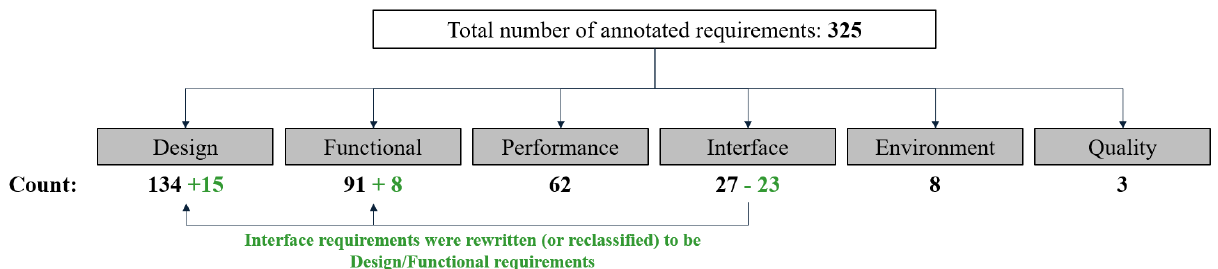
Figure 7. Six types of requirements were initially considered for the classification corpus. Due to the lack of sufficient examples for Interface, Environment, and Quality requirements, these classes were dropped at a later phase. However, some of the Interface requirements (23) were rewritten (or reclassified) to convert them into either Design or Functional requirements to include them in the final corpus, which only contains Design, Functional, and Performance requirements.